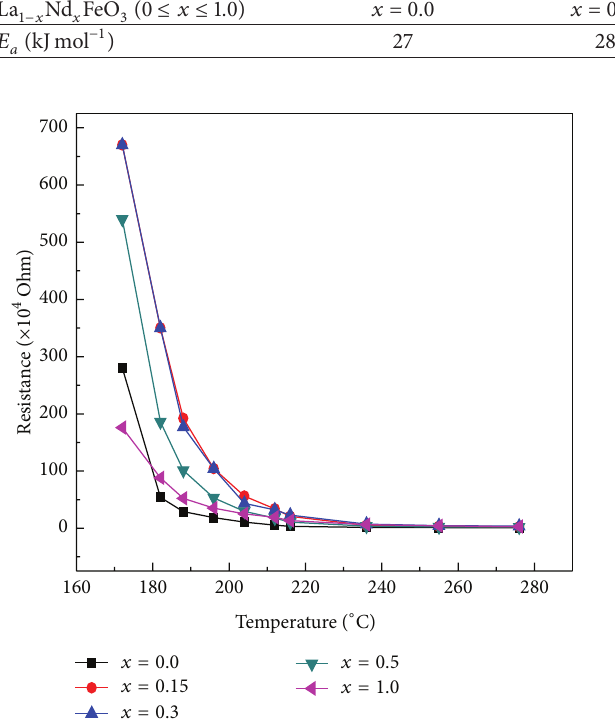
Figure 4: Electrical conductivity versus temperature of La 1−𝑥 Nd 𝑥 FeO 3 ( 𝑥 = 0.0 – 1.0 ) measured in